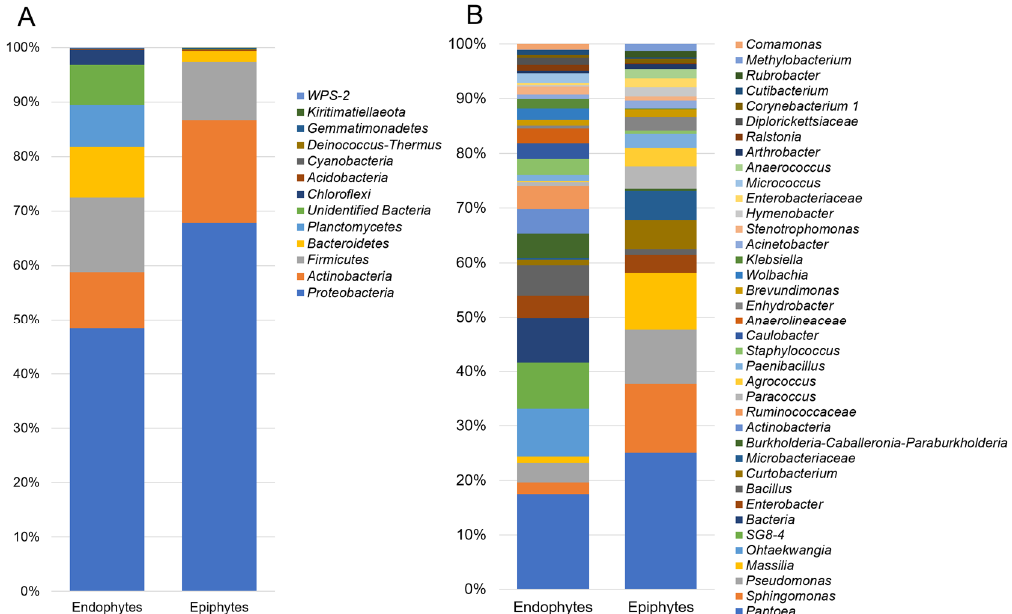
Figure 1. Bar charts showing the relative abundance of most dominant bacterial phyla ( A ) and genera ( B ) among endophytes and epiphytes detected in stored wheat grain samples using high-throughput sequencing technology.